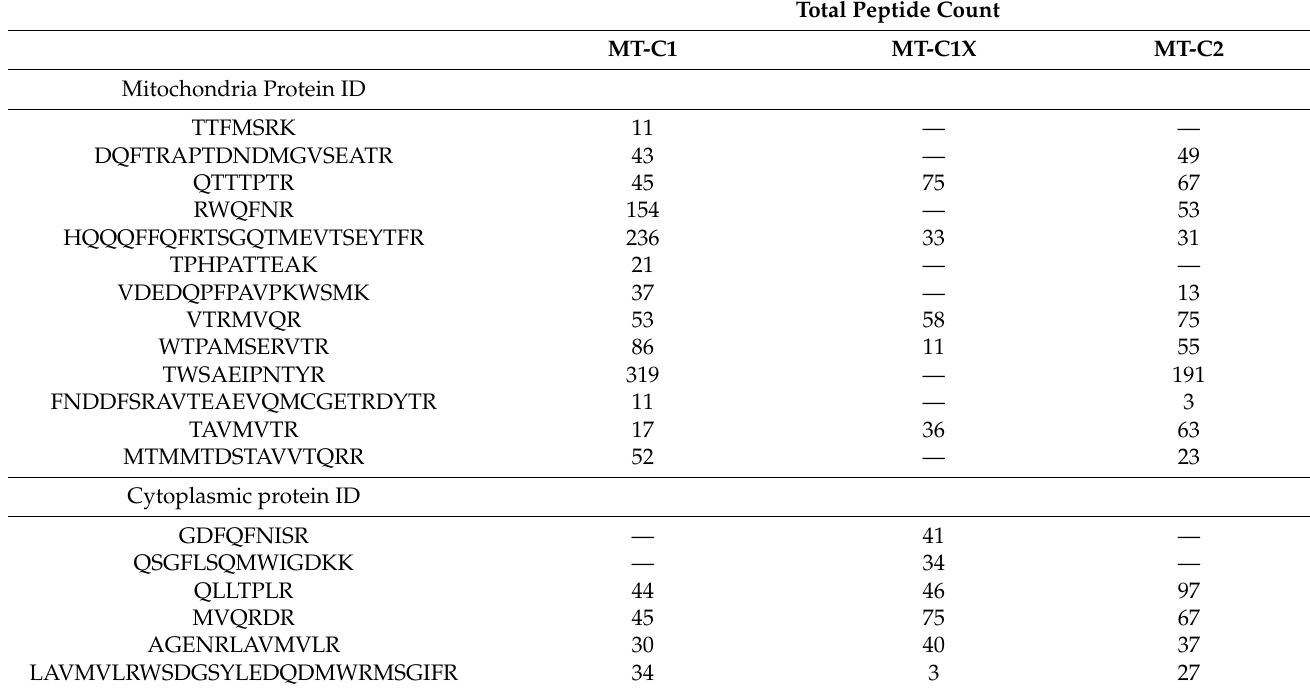
Table 1. Total peptide count reads of MT-C1, MT-C2, and MT-C1X mitochondrial proteins using Mass spectrometry. Runs were performed with mitochondrial specific protein IDs and cytoplasmic specific protein IDs. Peptide sequence for each are shown below. We were able to detect mitochondrial translation in the samples. As expected, MT-C1 that carries OXA1 3 (cid:48) -UTR and the 5 (cid:48) mitochondrial translation signal shows the highest reads compared to MT-C2 (carrying 5 (cid:48) mitochondrial translation signal only) and MT-C1X (carrying OXA1 3 (cid:48) -UTR and a mutated 5 (cid:48) mitochondrial translation signal). There are some reads in which MT-C1 is not showing the highest read, probably due to co-purification and background translation levels. For the cytosolic protein ID, we observe a closer range of reads for the three samples. Total Peptide Count MT-C1 MT-C1X